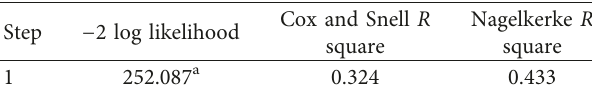
Table 9: Logistic regression model